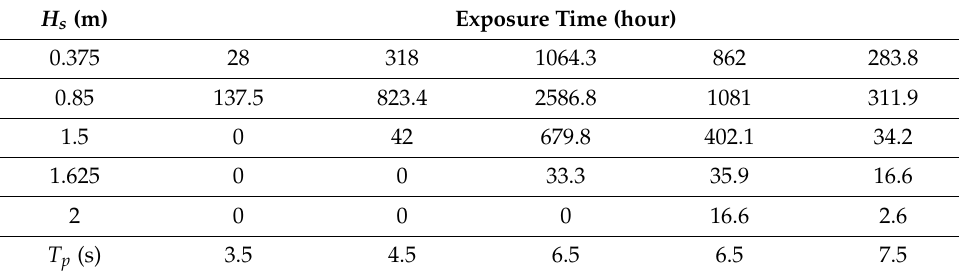
Table 6. Wave height-period distribution of the wind wave in West